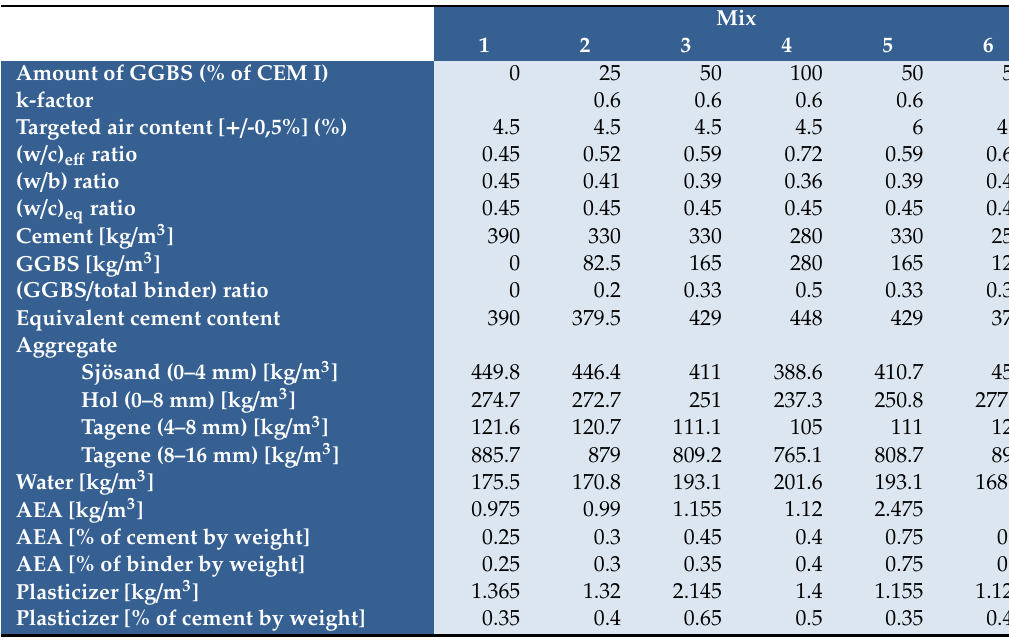
Table 1. Final mix